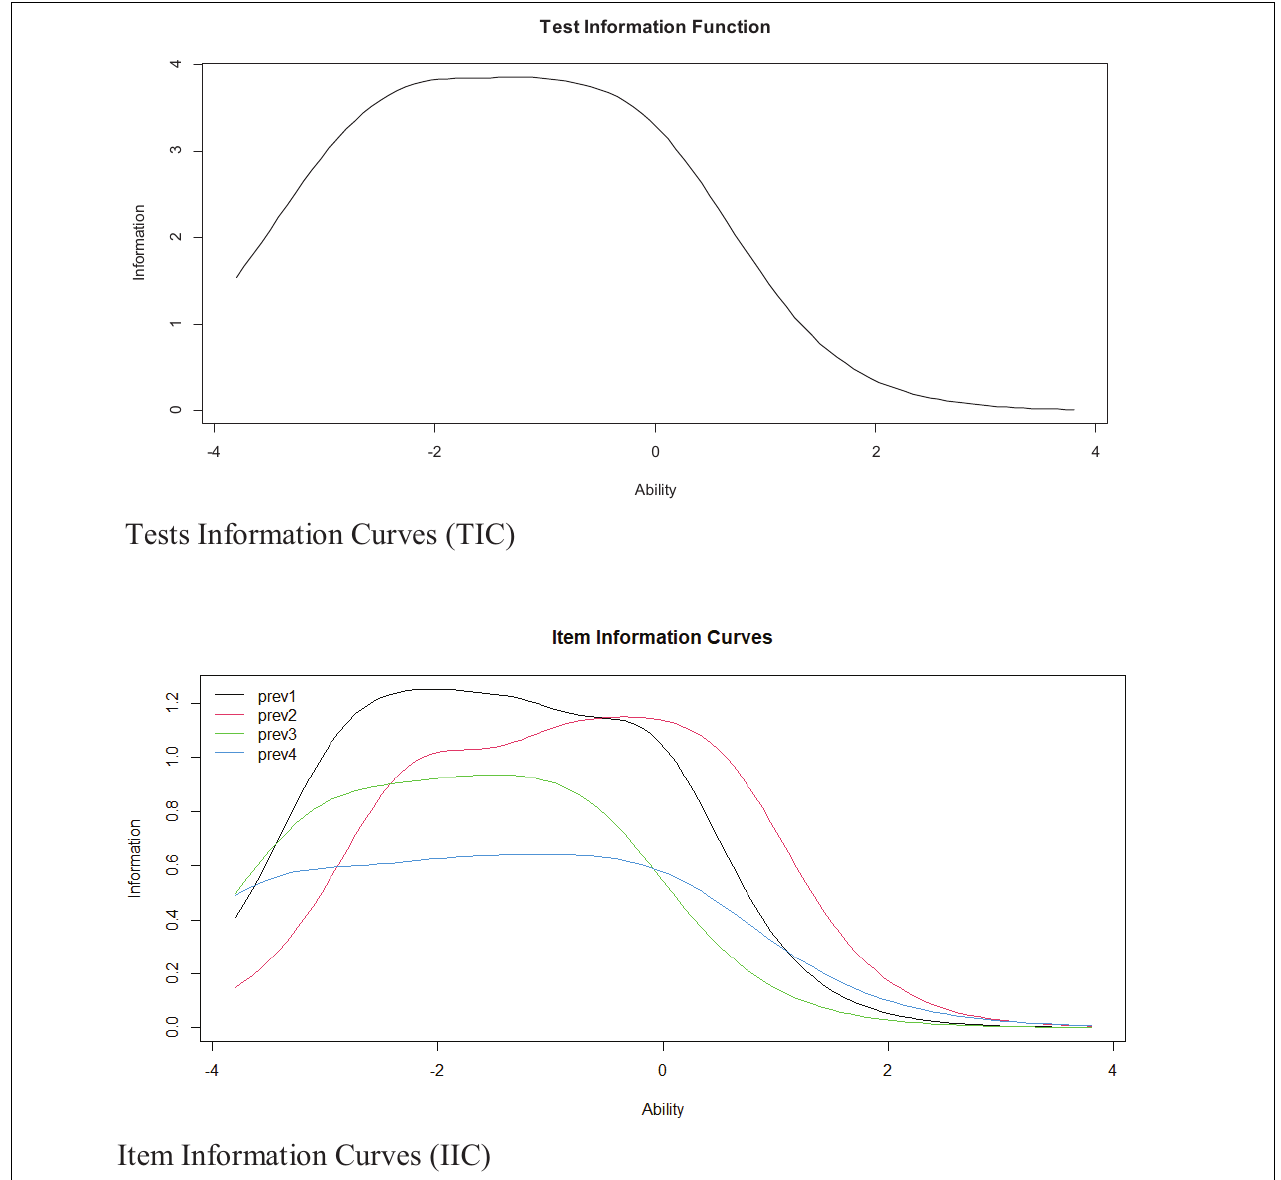
FIGURE 2 | Item and test information curves for the